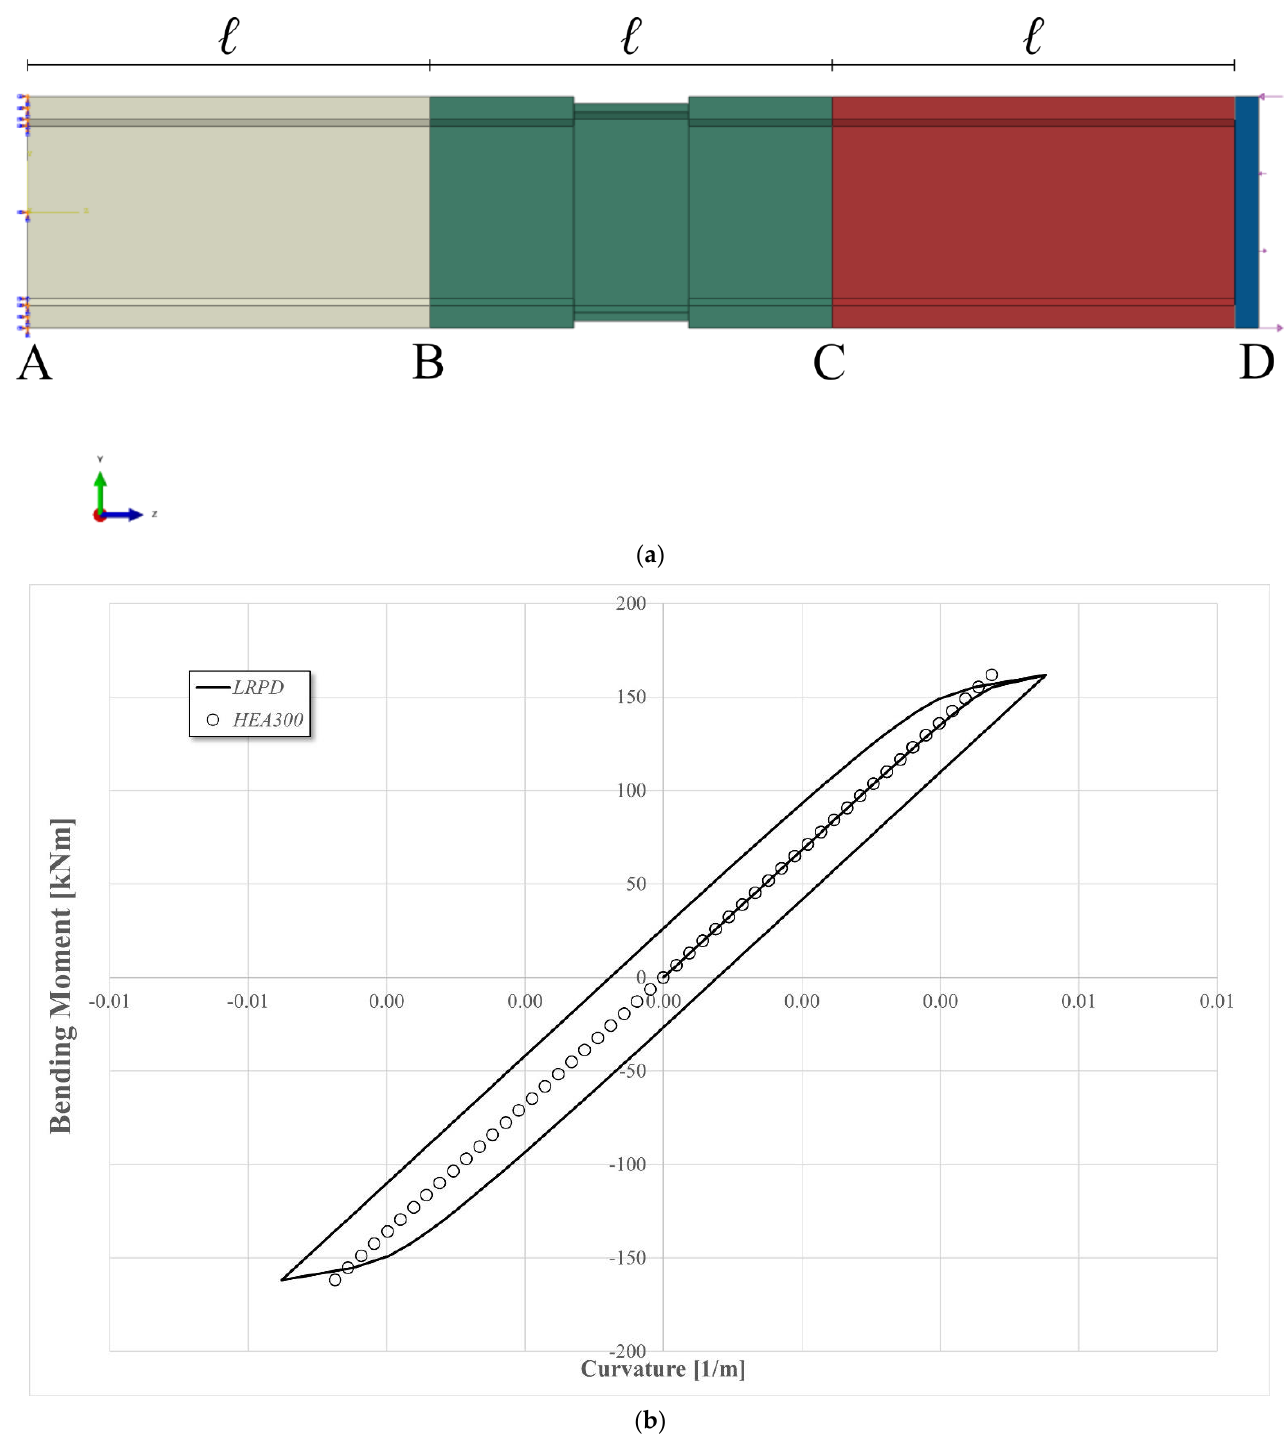
Figure 20. Cyclic analysis for HEA300 LRPD (DP1): ( a ) lateral view of the model; ( b ) bending moment vs. curvature curve.